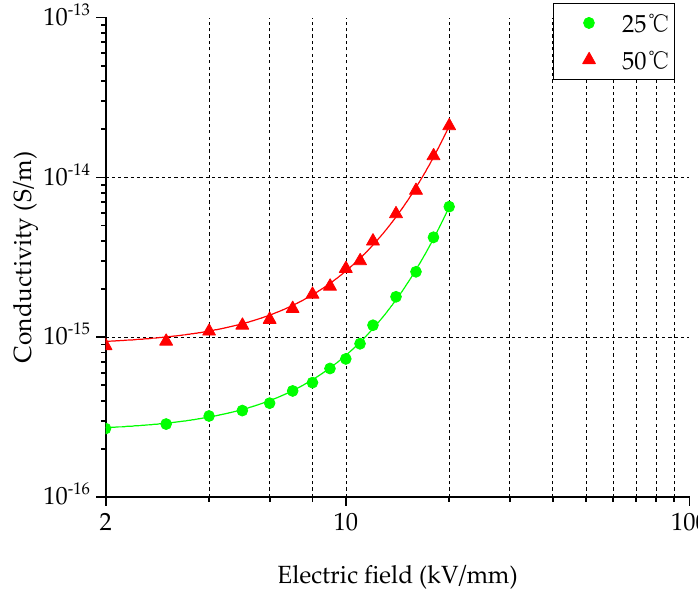
Figure 7. Change of the conductivity with the electric field at 25 °C and 50 °C.